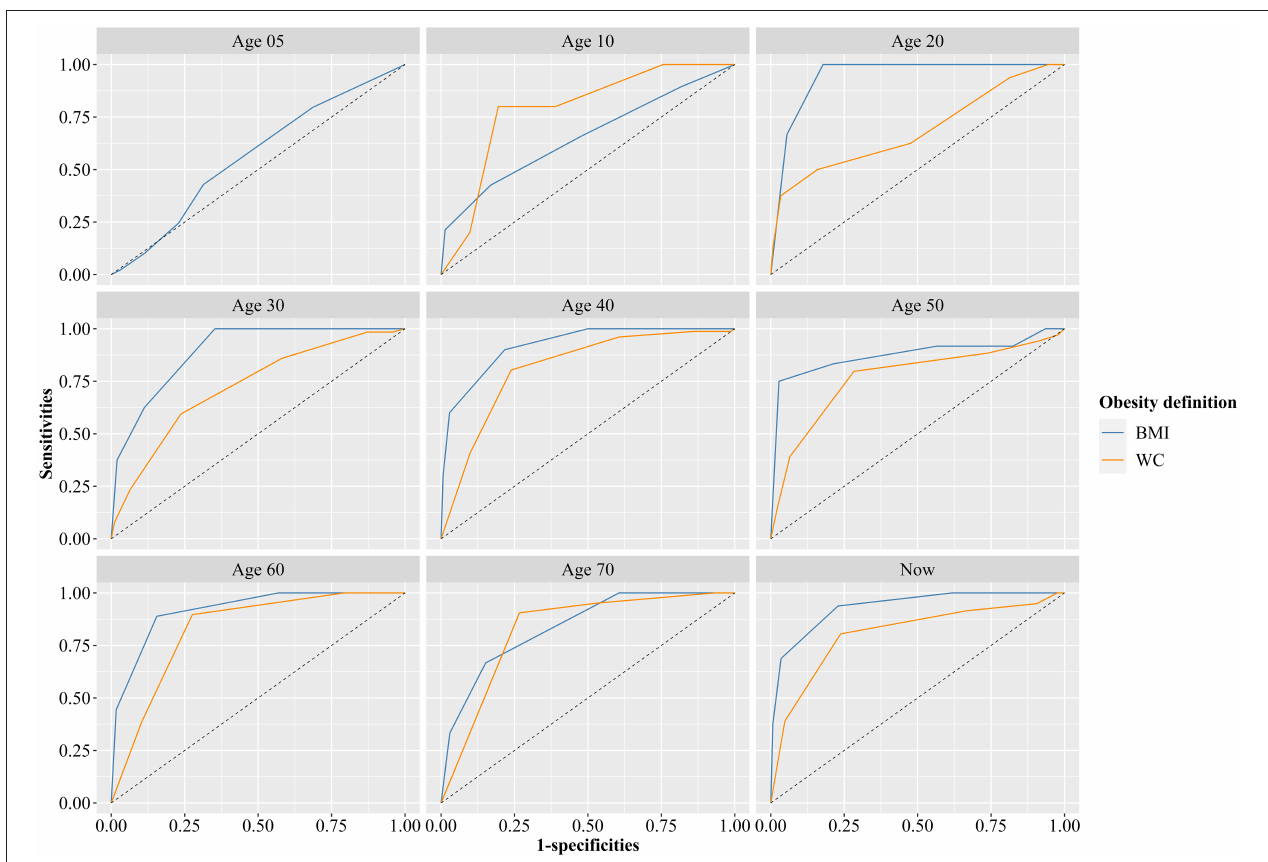
FIGURE 2 | Receiver operator characteristic curve of determining obesity by recall of body shape at different ages (Gold standard definition of obesity at age 5 was weight-for-height based on Chinese standard in 2009, gold standard definition of obesity at age 10 was BMI and WC classification criteria for screening Chinese school-age children developed by the China Working Group on